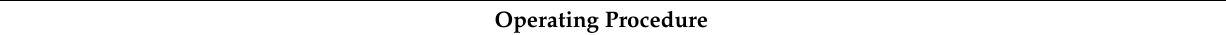
Table 5. Overall process (whole plant)-collection of useful information for BioHazOp